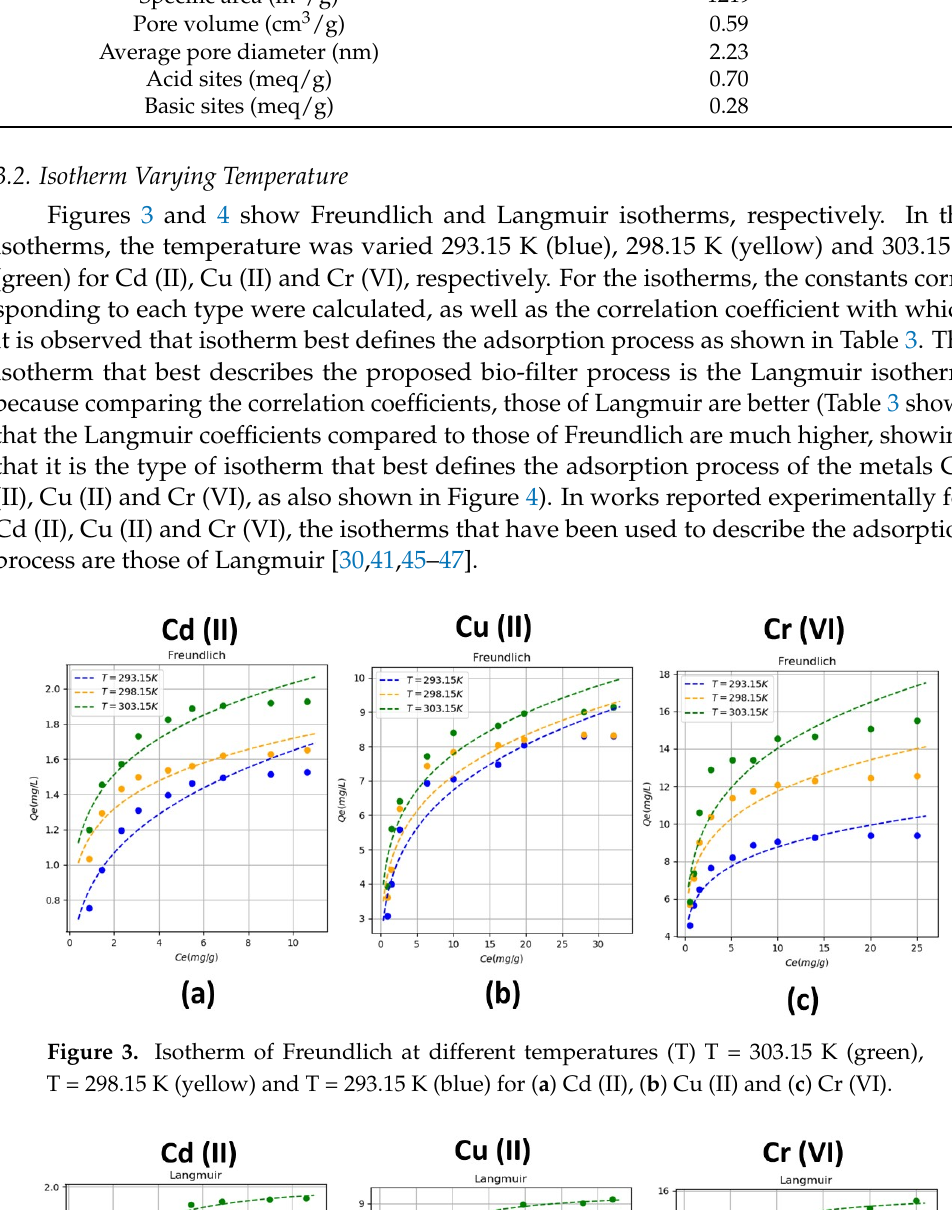
Table 2. Texture and physicochemical properties [44].